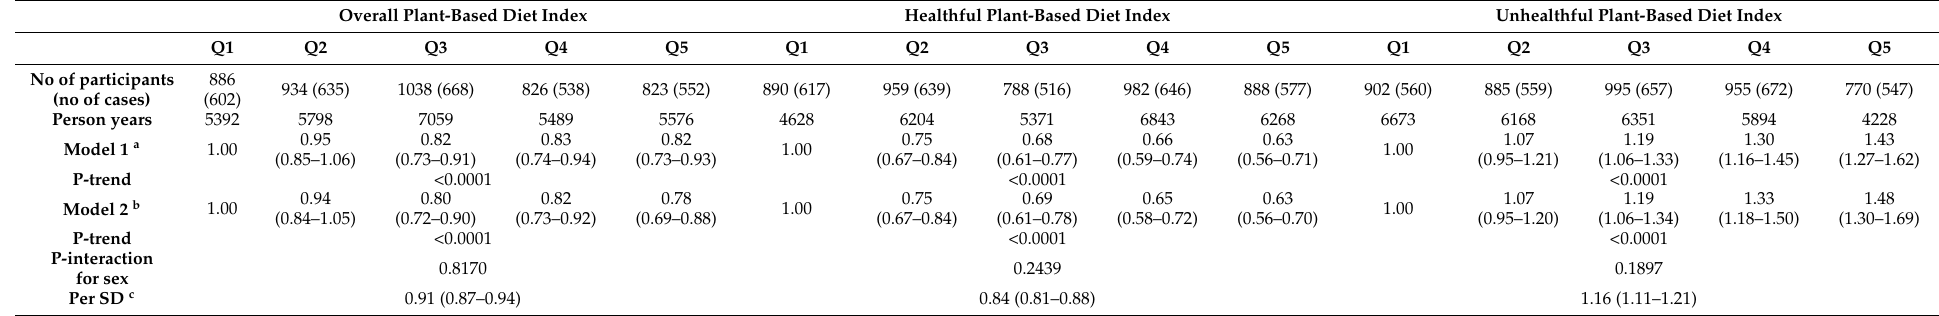
Table 2. Hazard ratios and 95% confidence intervals for incident dyslipidemia according to quintiles of plant-based diet scores among Korean adults.